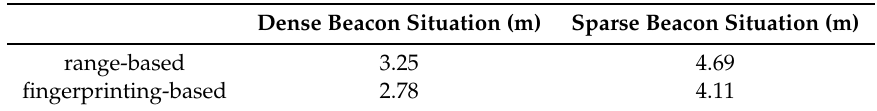
Table 5. Mean error comparisons for range-based positioning and fingerprinting-based positioning using estimated beacon positions and RFM.